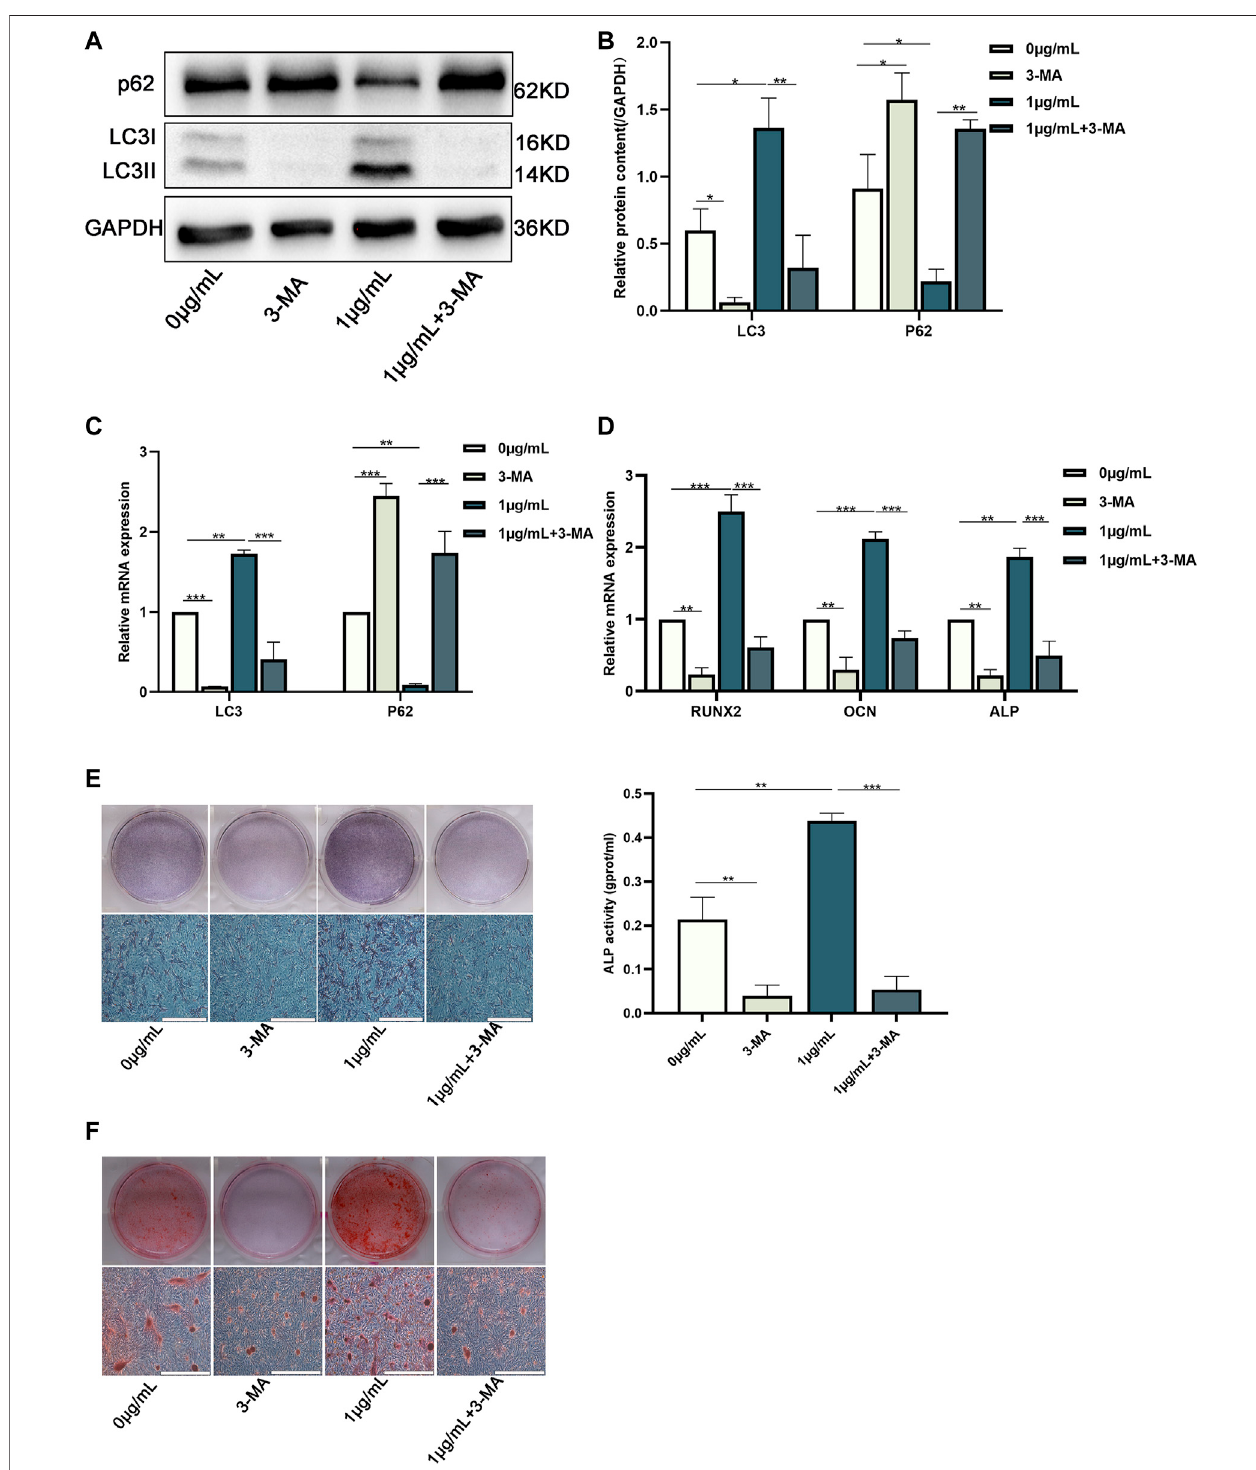
FIGURE5| DownregulationofautophagyinhibitedtheosteogenicdifferentiationofBMSCstreatedwithCHNQD-00603.BMSCsculturedwithorwithoutCHNQD- 00603weretreatedwith5-µM3-MAandtheninducedforosteogenicdifferentiation.Thelevelofautophagyandosteogenesiswasanalyzedonday7. (A,B) Autophagy- related proteins LC3 and p62 were detected by Western blot and quantitation. (C) Autophagy-related genes LC3 and p62 were assessed by qRT-PCR. (D) Osteogenesis-related genes Runx2, OCN, and ALP were tested by qRT-PCR. (E) ALP staining and ALP activity assay indicated early osteogenic differentiation (scale bar (cid:1) 200 µm). (F) ARS was used to detect calcium salt deposits on day 14 (scale bar (cid:1) 200 µm). Quantitative data are presented as the mean ± SD (n (cid:1) 3) (* p < 0.05, ** p < 0.01, *** p < 0.0001).